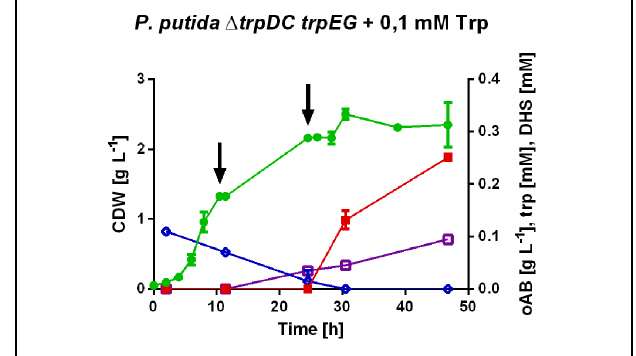
• FIGURE 3 | Detailed profiles of , cell dry weight; (cid:2) , oAB; ♦ , tryptophan (trp); (cid:4) , dehydroshikimate (DHS) concentrations of the best selected strain P. putida KT2440 (cid:2) trpDC pSEVA234_ trpE S40F G generated under slightly optimized production conditions. All cultures were performed in mineral medium with 20 mM initial glucose concentration and addition of tryptophan and/or phenylpyruvate as described above. The arrows indicate the addition of glucose to a concentration of 20